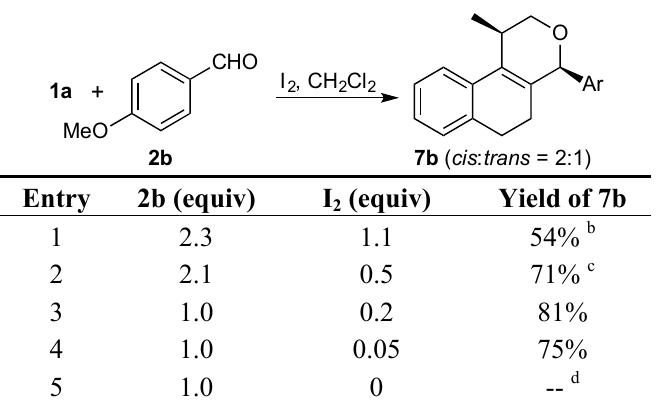
Table 1. Prins cyclization of 1a and p -anisaldehyde ( 2b ) a